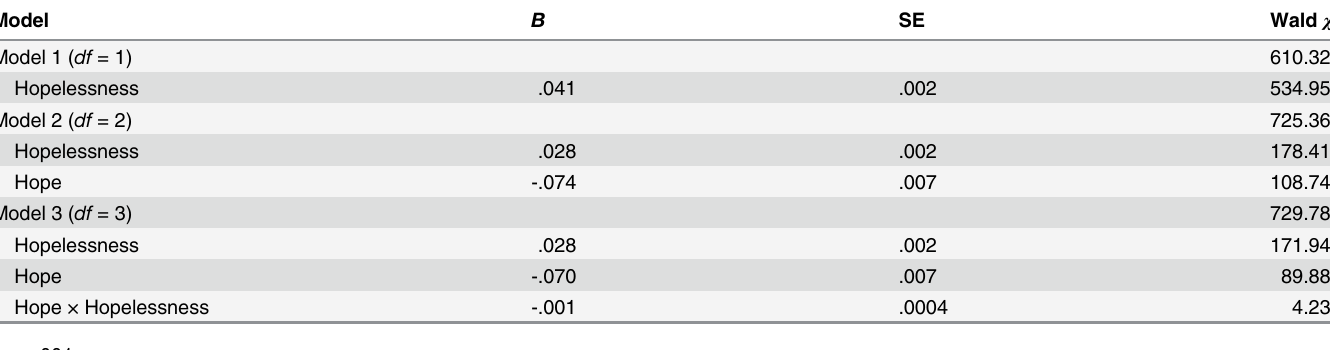
Table 3. Negative Binomial Regression Analyses Predicting Suicidal Ideation.